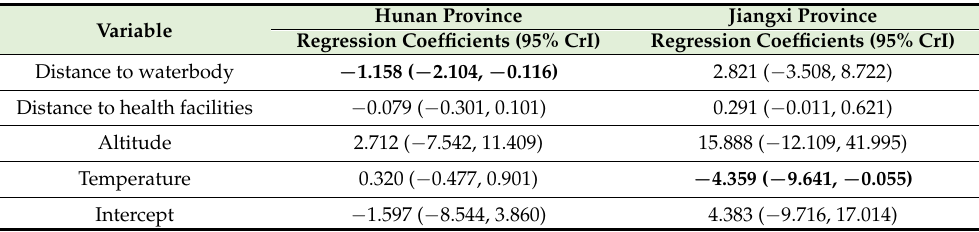
Table 4. Regression coefficient mean and 95% credible intervals (CrI) of covariates included in a Bayesian spatial model with Binomial response for the prevalence of schistosomiasis.